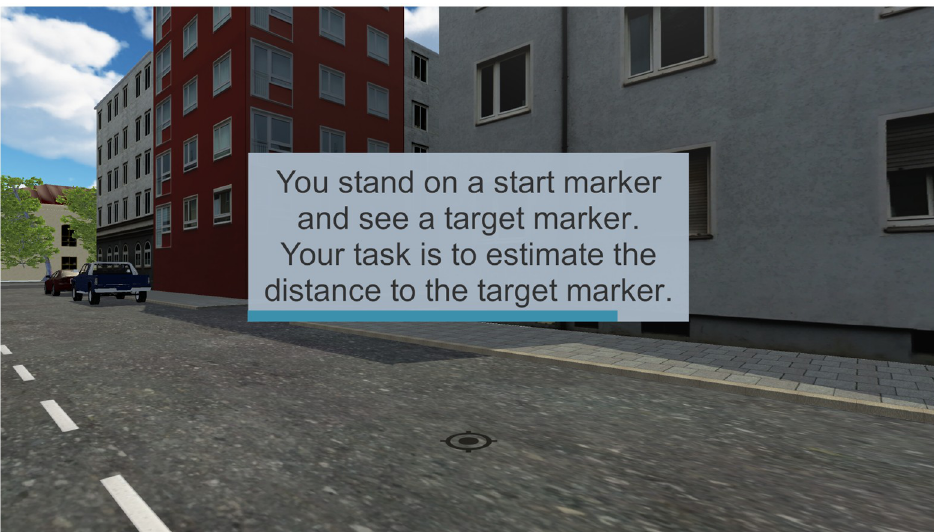
Fig 1. Virtual environment. The virtual environment replicates a typical Munich city street scenario. The environment is rich in pictorial depth cues (e.g. occlusion, shadows, relative size of familiar objects, textures gradients, and linear perspective). The scene shows a target marker to which the participants had to estimate the virtual distance. In the experiment, the written instructions were given in German. The progress bar at the bottom of the text box indicates the remaining time to read the